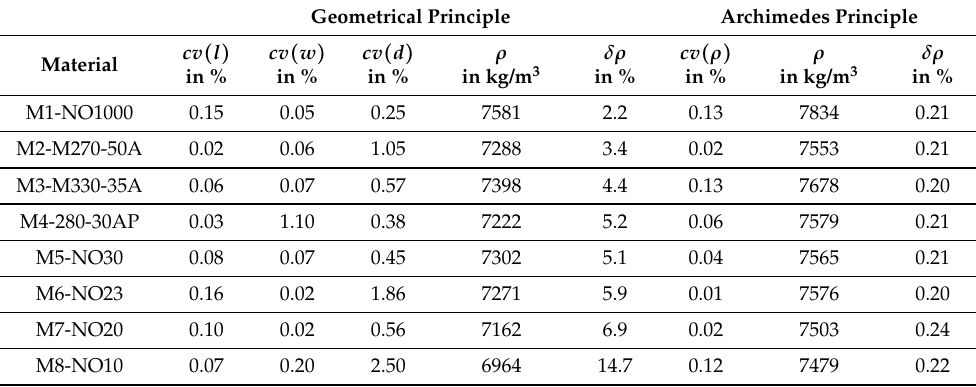
Table 6. Measurement results and error estimation of the density measurement at ϑ ≈